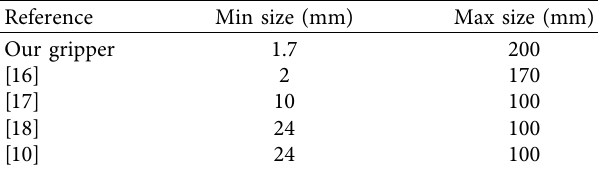
Table 7: Comparison of grasping results.